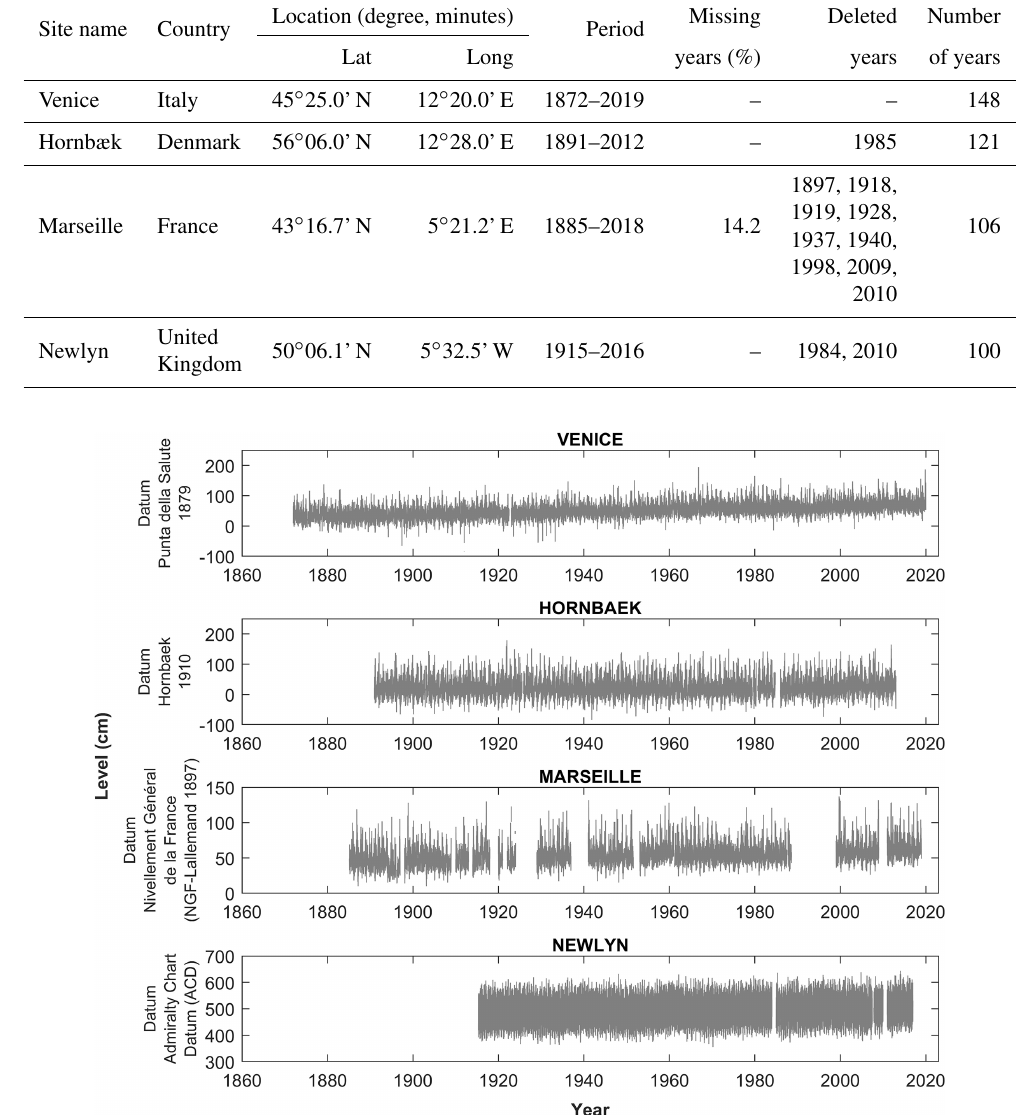
Figure 1. Daily maximum sea levels at different gauge stations explored after pre-processing: Venice (IT), Hornbæk (DK), Marseille (FR), and Newlyn